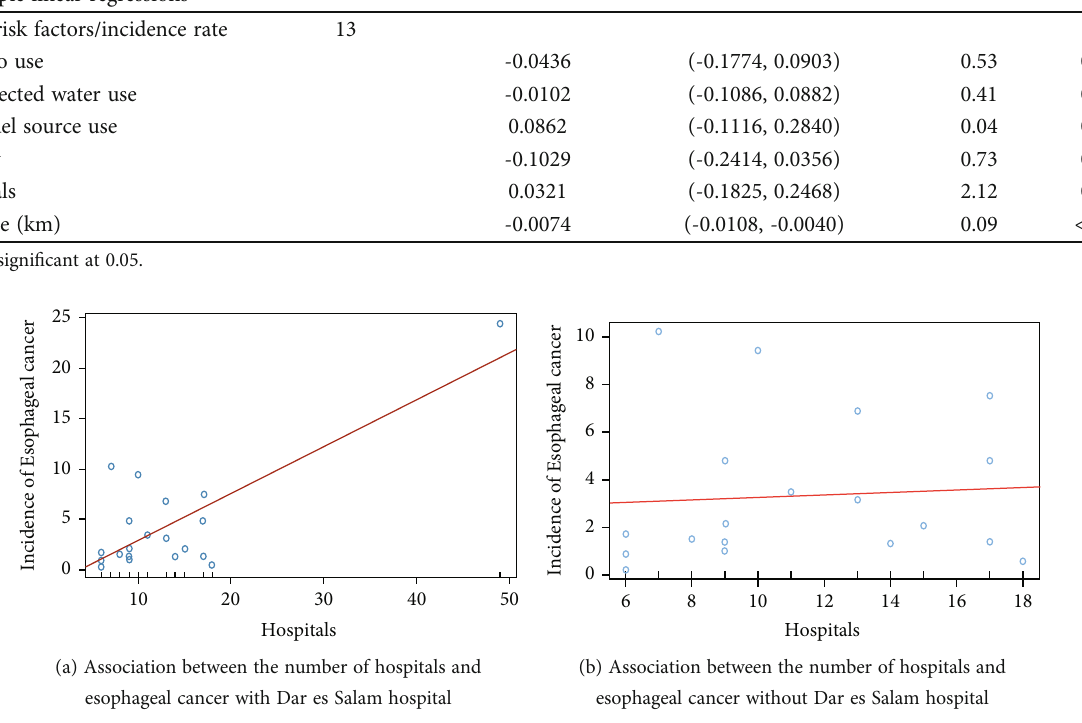
Figure 1: Associations between the number of hospitals and esophageal cancer incidence with or without Dar es Salam